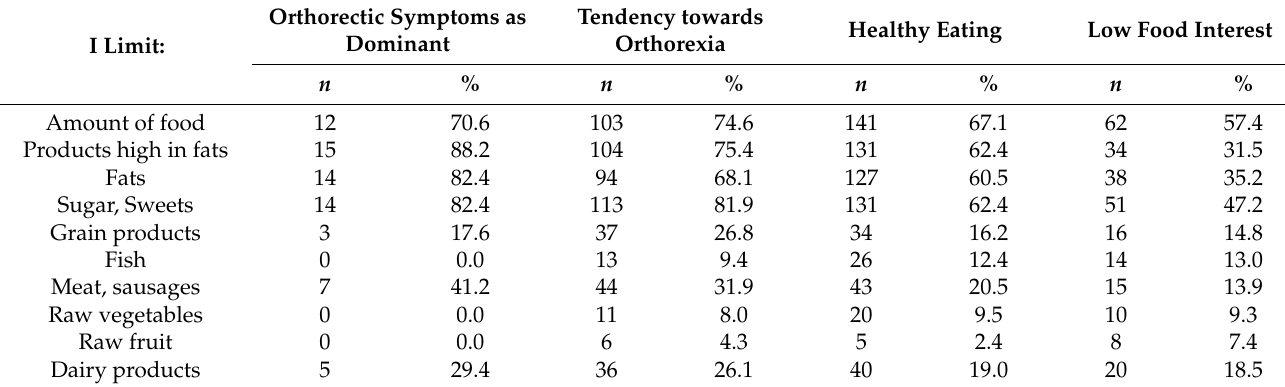
Table 3. Restrictions of specific products in specified groups based on the ORTO-6 questionnaire.